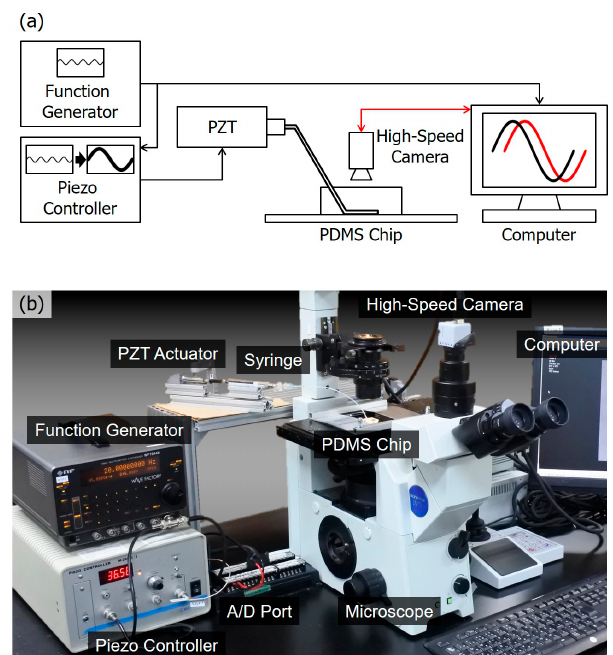
Figure 3. An overview of the experimental system. ( a ) A diagram of the system setup. The motion of the piezoelectric (PZT) actuator is controlled by a sinusoidal wave generated from a function generator while the motion of microbeads is recorded by a high-speed camera. The two motions are synchronized on the computer for analysis; ( b ) a photo of the actual system setup.